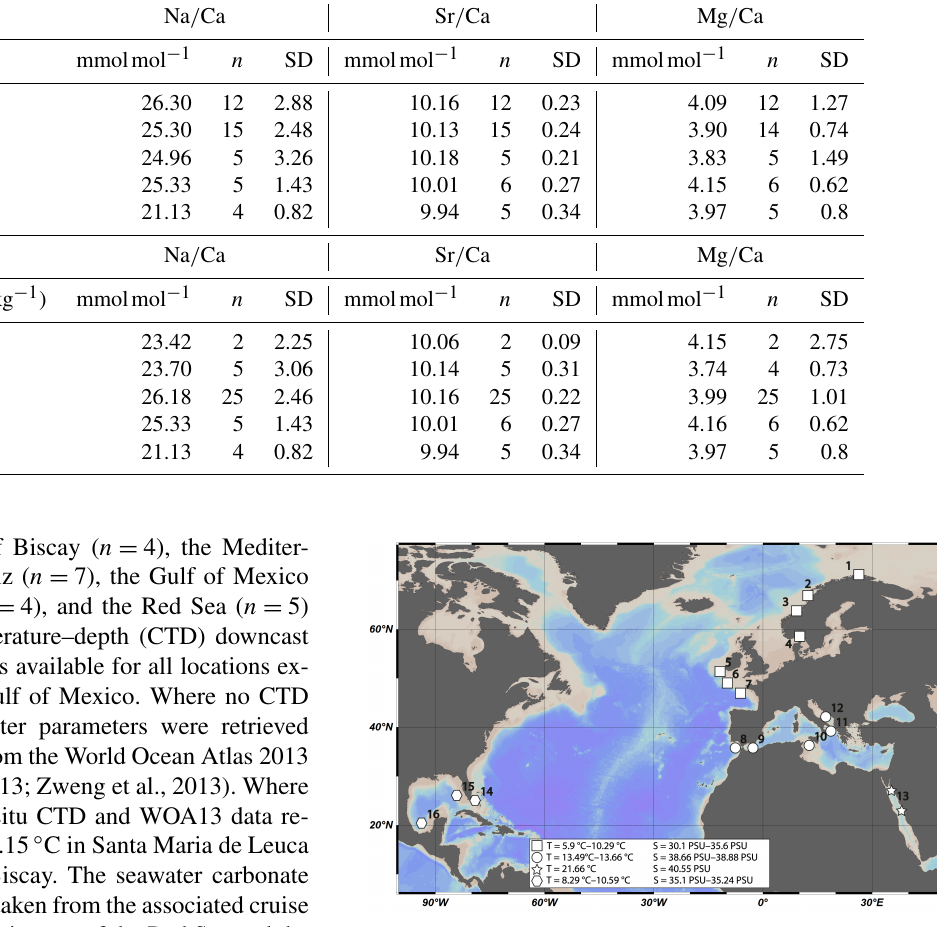
Figure 1. Map of sampling locations. Locations are grouped in four areas with similar physical parameters. (1) Lopphavet, Sot- bakken, Stjernsund; (2) Traenadjupet; (3) Sula, Nordleksa, Tautra, Røberg; (4) Oslofjord; (5) Galway Mound; (6) Whittard Canyon; (7) Guilvinec Canyon; (8) Meknes Carbonate Mound Province; (9) El Idrissi Bank; (10) Urania Bank; (11) Santa Maria di Leuca (SML) province; (12) Bari Canyon; (13) Red Sea; (14) Great Ba- hama Bank; (15) southwest Florida; (16) Campeche